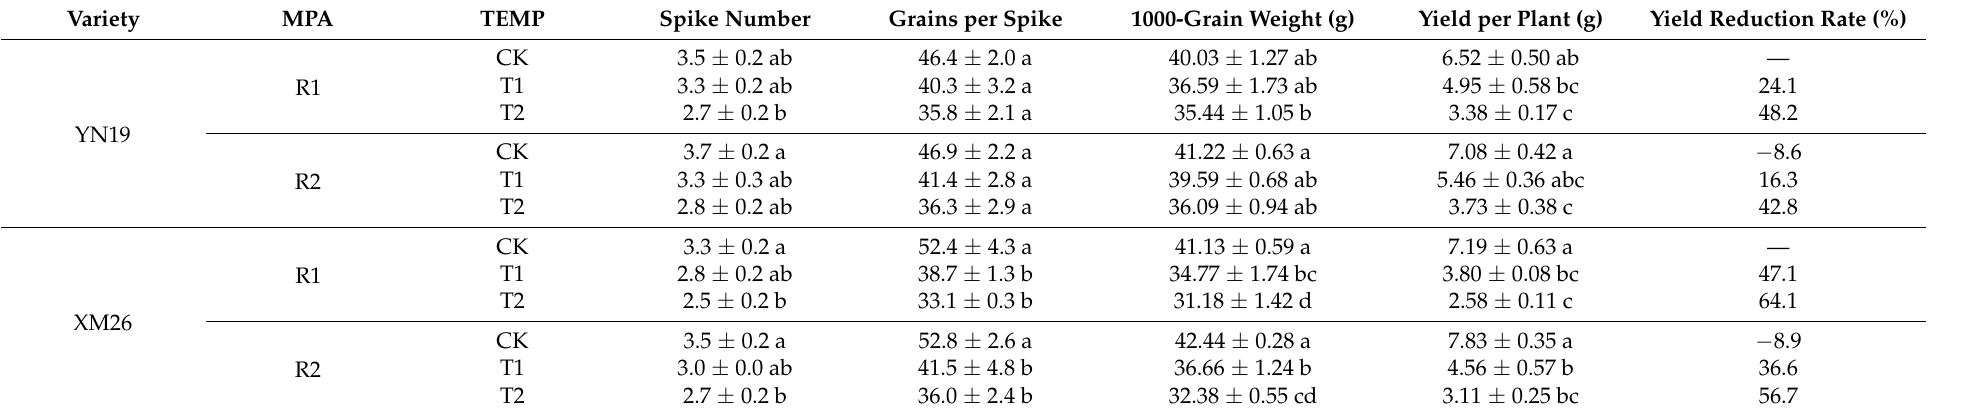
Data represent mean ± SE ( n = 3). Different letters following the data within each column indicate significant differences at p < 0.05. Abbreviations: YN19 = Yannong19; XM26 = Xinmai26; MPA = the methods of phosphorus application; TEMP = temperature. R1 and R2 represent traditional phosphorus application and optimized phosphorus application, respectively. CK, T1 and T2 represent 11 ◦ C, 4 ◦ C and − 4 ◦ C,